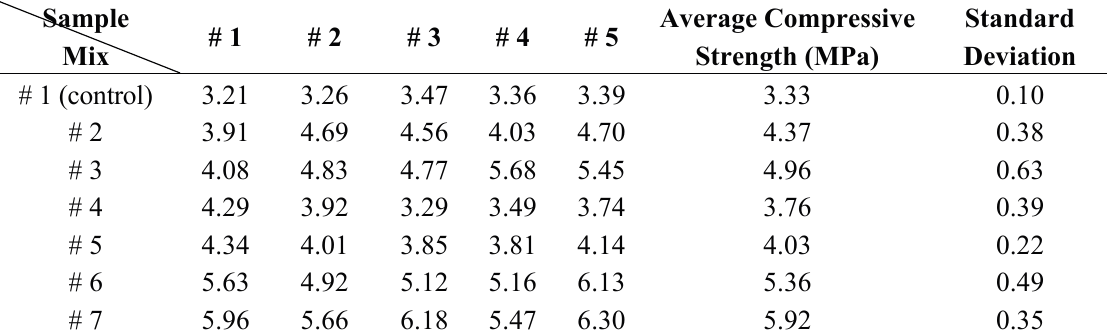
Table 4. Average compressive strength results of